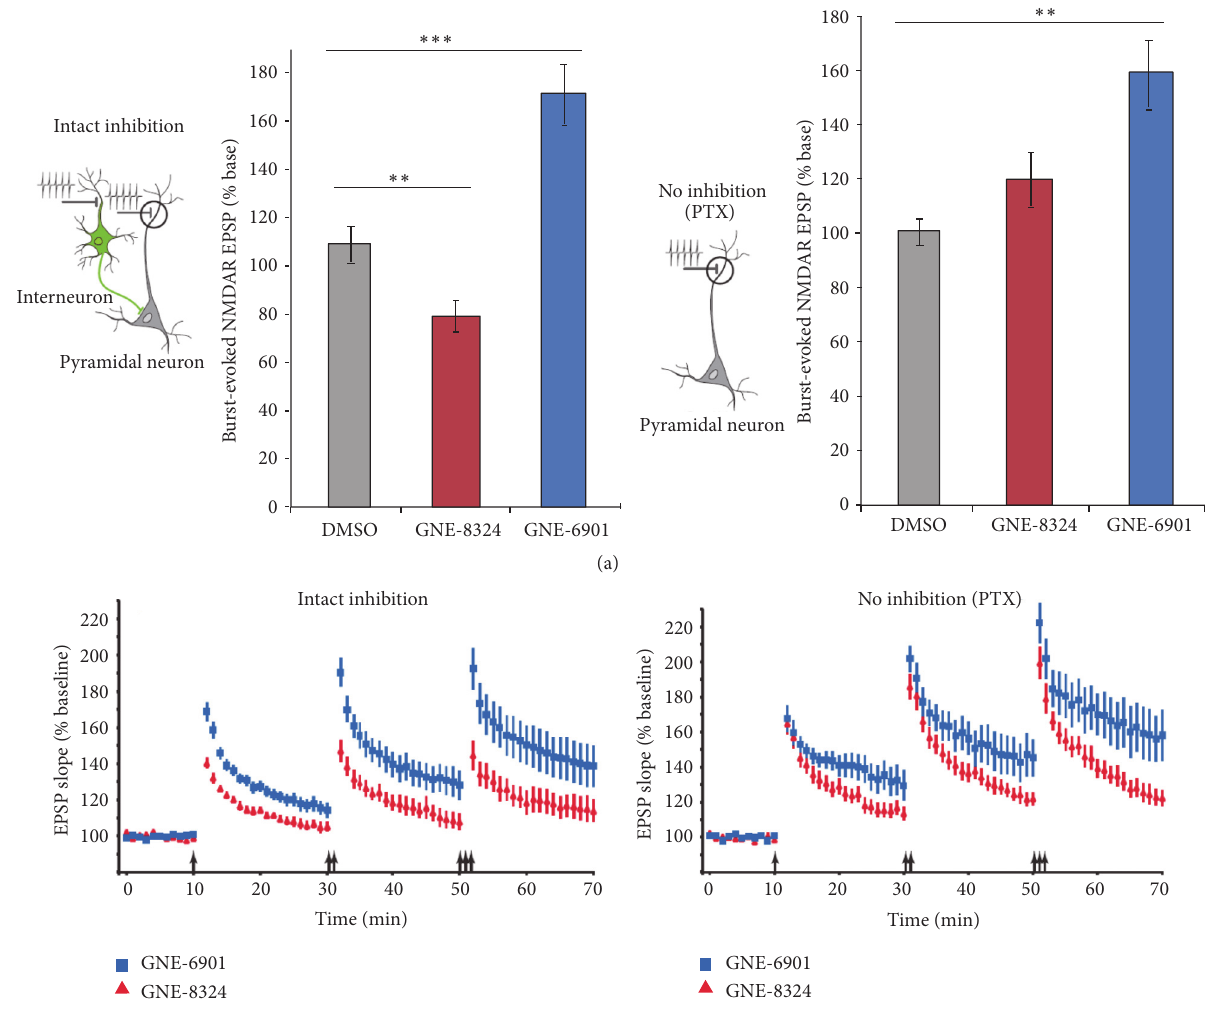
Figure 2: Differential effects on NMDARs underlie different modification of synaptic plasticity by GNE-PAMs. (a) NMDAR-mediated responses during TBS were calculated and showed differences between GNE-8324 and GNE-6901 which further depends on whether inhibition is present. With intact inhibition, GNE-6901 enhanced while GNE-8324 reduced NMDAR responses, compared to controls. When inhibition was absent, GNE-8324 showed a small, nonsignificant enhancement. (b) Consistent with the above effects on NMDAR responses, GNE-6901 enhanced LTP regardless of whether inhibition was present, while GNE-8324 enhanced LTP in the absence of inhibition but reduced LTP when inhibition was intact. Modified from